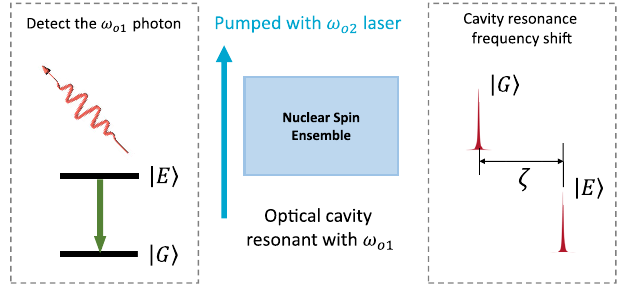
FIG. 4. Readout of the quantum state of the NSE. Left box: the cavity is on resonance with the ONQ transition, and one can detect whetherthe ω photonisemittedtodeterminethestateoftheNSE. o 1 Right box: an anharmonic cavity is off resonance with the ONQ transition.Onecandetect theshift intheresonance frequencyofthe cavity to determine the quantum state of the